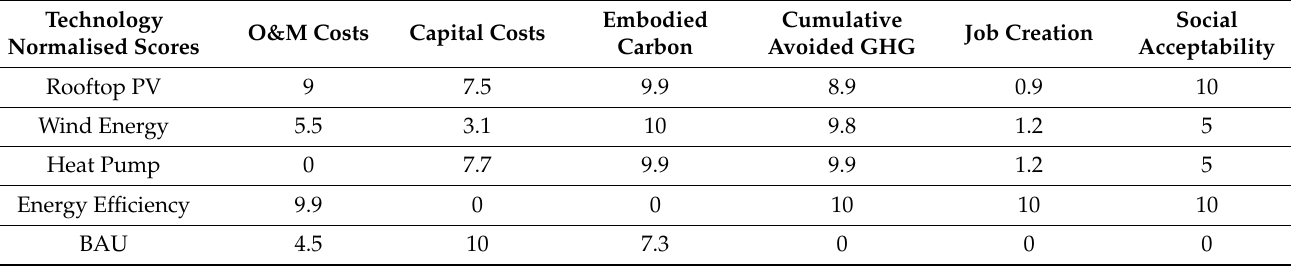
Table 6. The indicator outputs and normalisation.